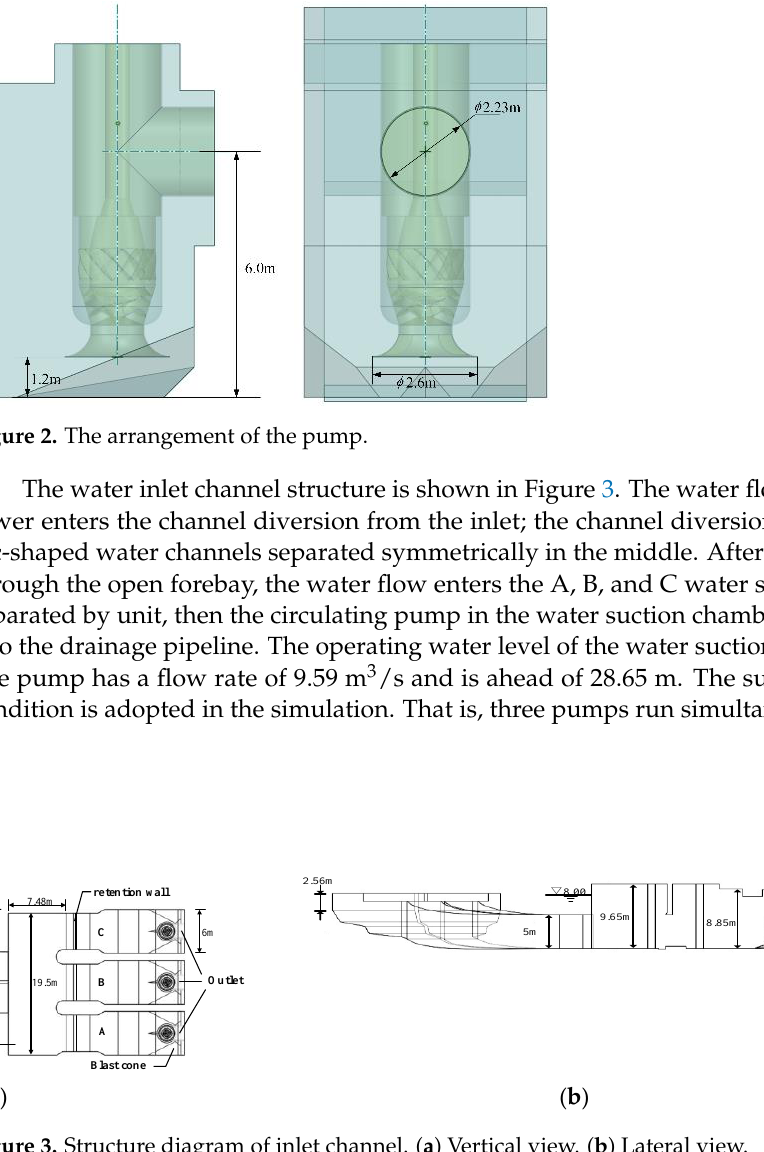
Figure 1. Circulating pump structure.